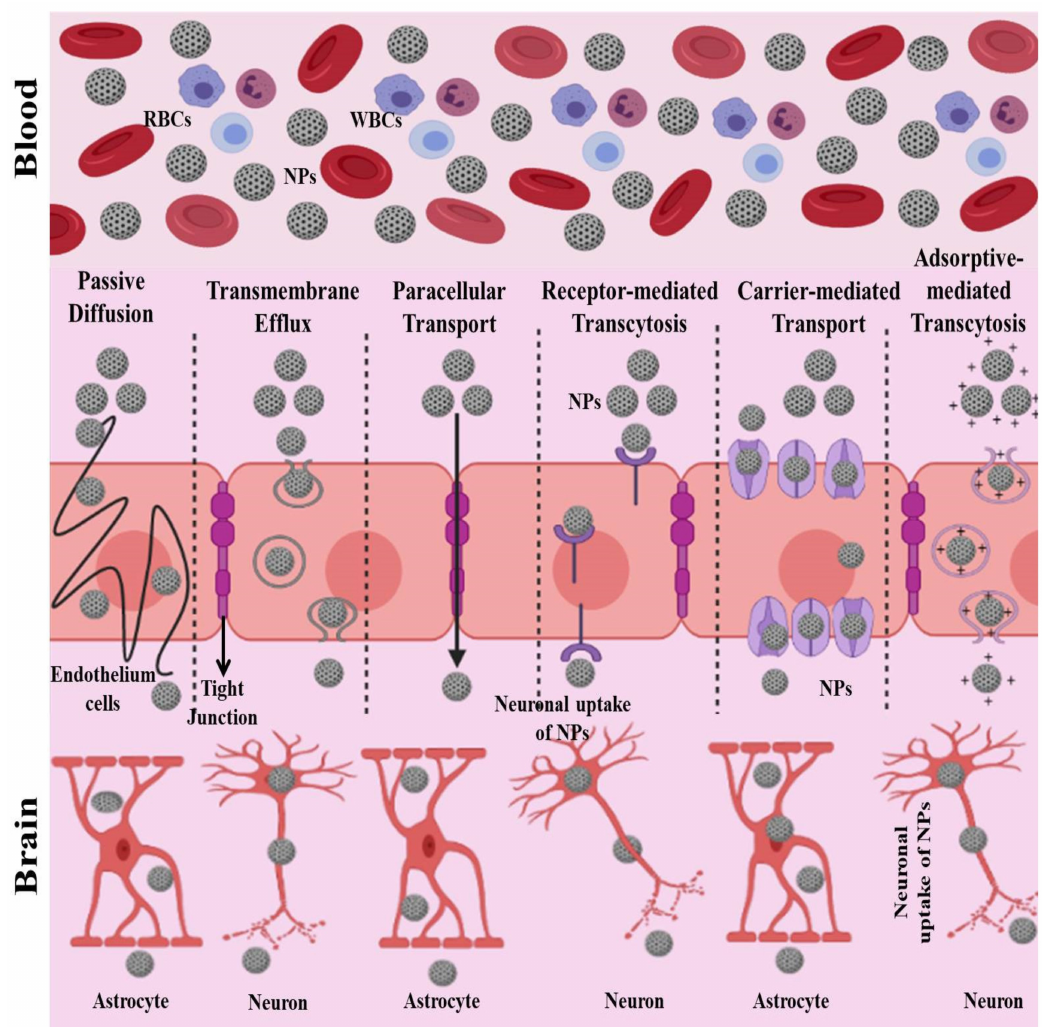
Figure 3. Schematic representation of the various proposed pathways by which NPs can cross the blood–brain